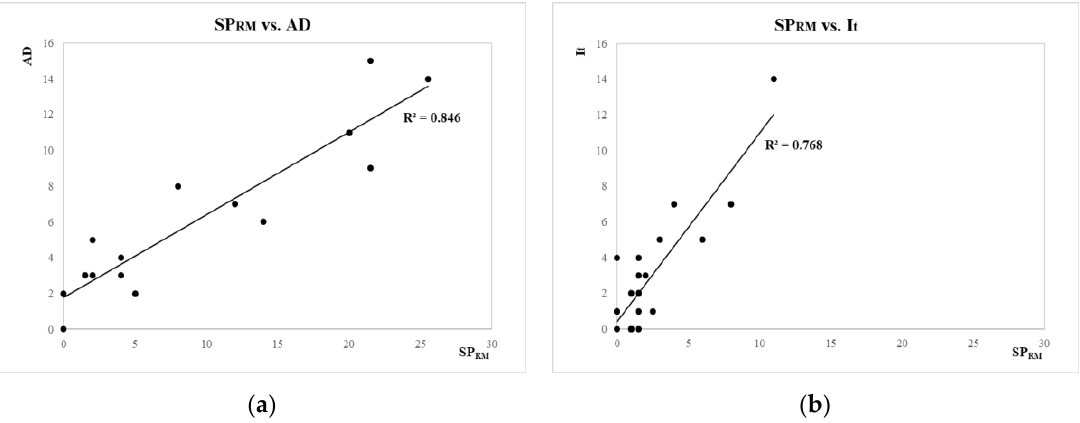
Figure 8. Safety performance, road markings (SP RM ) vs. accidents per kilometre (AD) and I t for urban ( a ) and rural ( b ) environments, respectively.